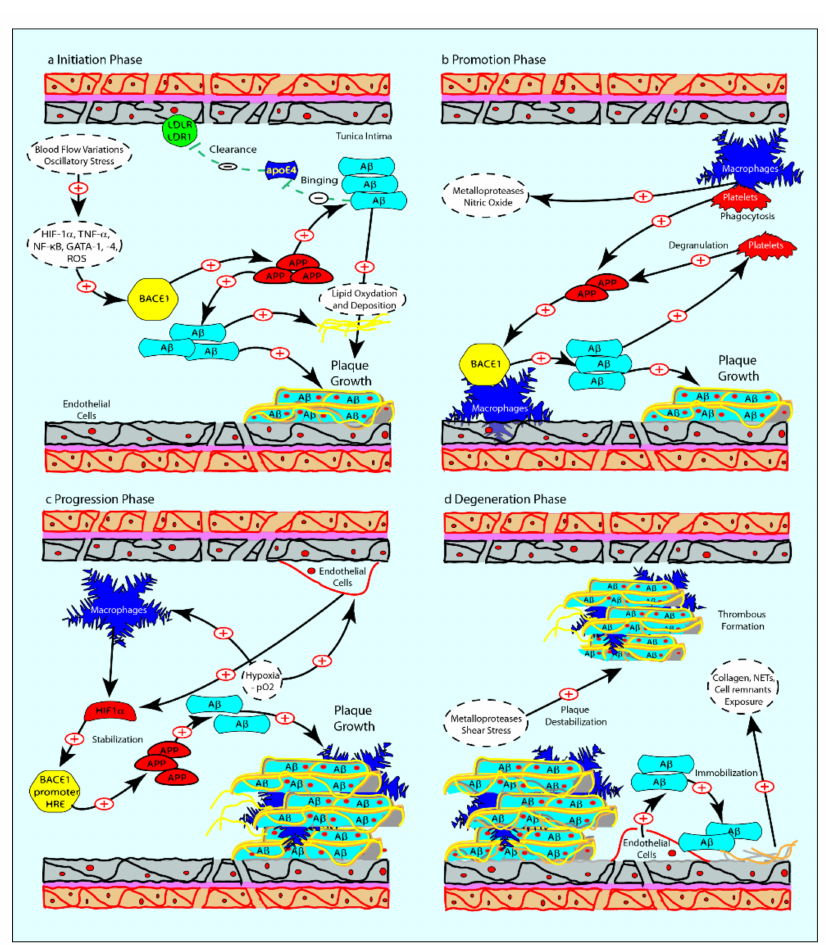
Figure 2. ( a ) Schematic representation of A β contribution to atherosclerotic plaque formation. Flow variations cause endothelial cell dysfunction and induce HIF-1 α , TNF- α , NF- κ B, GATA-1 and GATA-4, causing the increase of APP processing and A β production in endothelial cells. A β also promotes the activation of endothelial cells, which increase LDLR and LRP1 on the cell membrane. As a result, there is an accumulation of lipids in the tunica intima of blood vessels; ( b ) during the promotion phase, macrophages phagocytize APP, which is then processed by BACE1, increasing local and circulating A β concentration and stimulating the production of nitric oxide and metalloproteases. The presence of A β in atherosclerotic plaques is also explained by its production in both endothelial cells and platelets; ( c ) the hypoxic condition leads to HIF-1 α binding HRE on the BACE1 promoter, in both endothelial cells and macrophages, increasing A β production and formation of the atheroma; ( d ) in the degeneration phase, matrix metalloproteases and apoptosis destabilize atherosclerotic plaque, causing cell death and the exposition of collagen, neutrophil extracellular traps (NETs) and membranes on which A β can be immobilized, causing extracellular amyloid